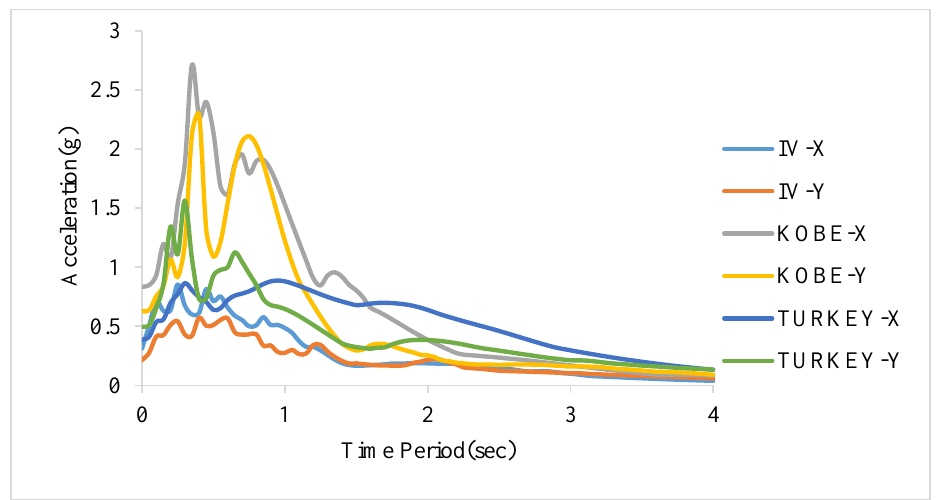
Figure 5. Selected recorded earthquake motion time histories .